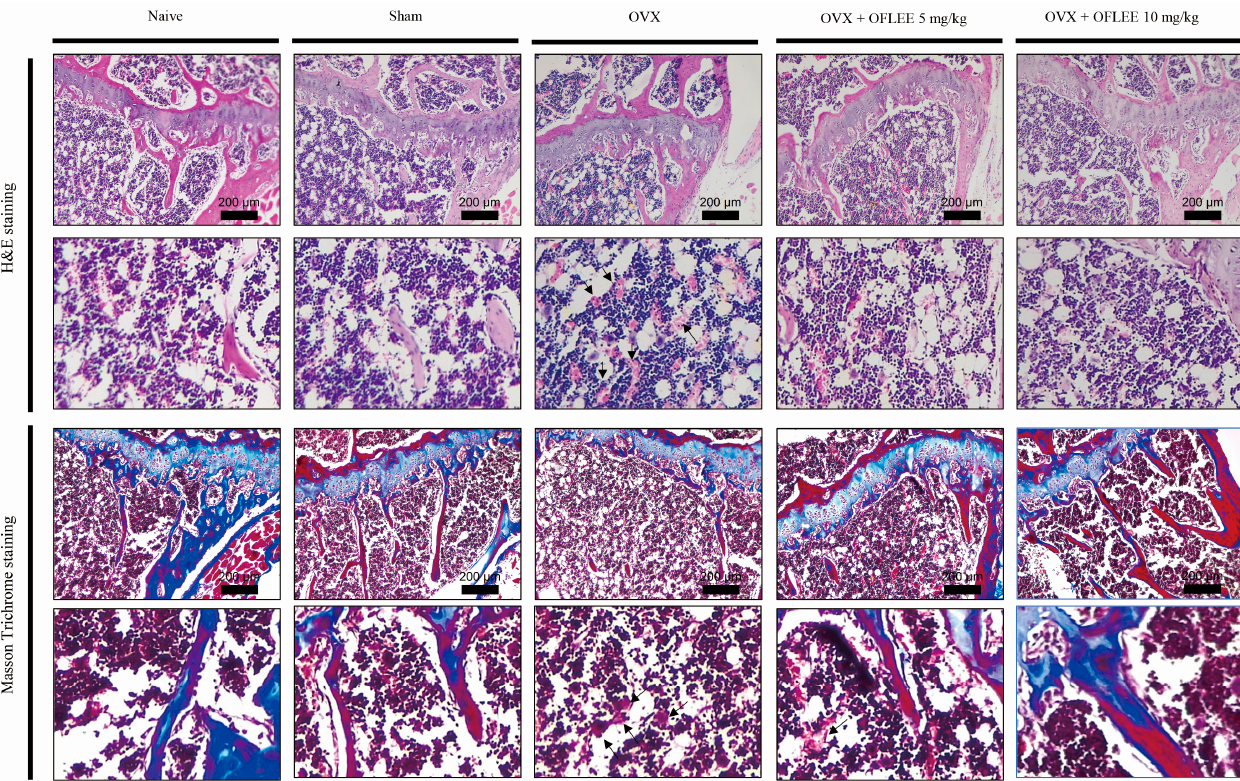
Figure 8. The oral supplementation of OFLEE prevented osteoclastic bone loss via the suppression of osteoclastogenesis in the experimental animals with OP generated by OVX. To perform the histological analysis, the femoral bones dissected from experimental animals were decalcified by 15% ethylenediamine tetraacetic acid (EDTA) for 10 weeks. Thereafter, decalcified femoral bones were embedded in paraffin and incised into 8 μ m slices. The samples were stained with H&E and Masson trichrome. Hematoxylin and eosin staining showed the increase of empty lacunas and osteoclasts (indicated by black arrow) in the femoral bones dissected from the OVX group compared with naïve, sham, OVX orally supplemented with 5 mg/kg or 10 mg/kg OFLEE groups ( the upper panel ). Masson trichrome staining showed that new bone collagen fibers, stained a blue color, and mature bone, stained a red color, were higher than naïve, sham, OVX orally supplemented with 5 mg/kg or 10 mg/kg OFLEE groups compared with OVX group ( the lower panel ).